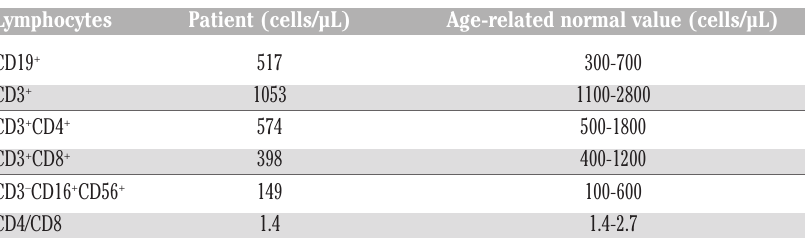
Table 1. Lymphocyte subsets – absolute number.